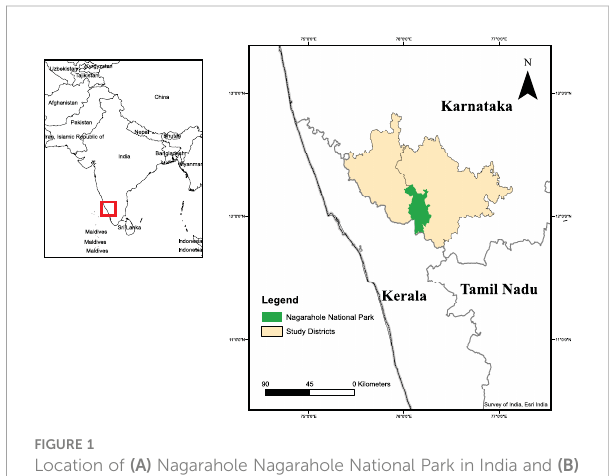
FIGURE 1 Location of (A) Nagarahole Nagarahole National Park in India and